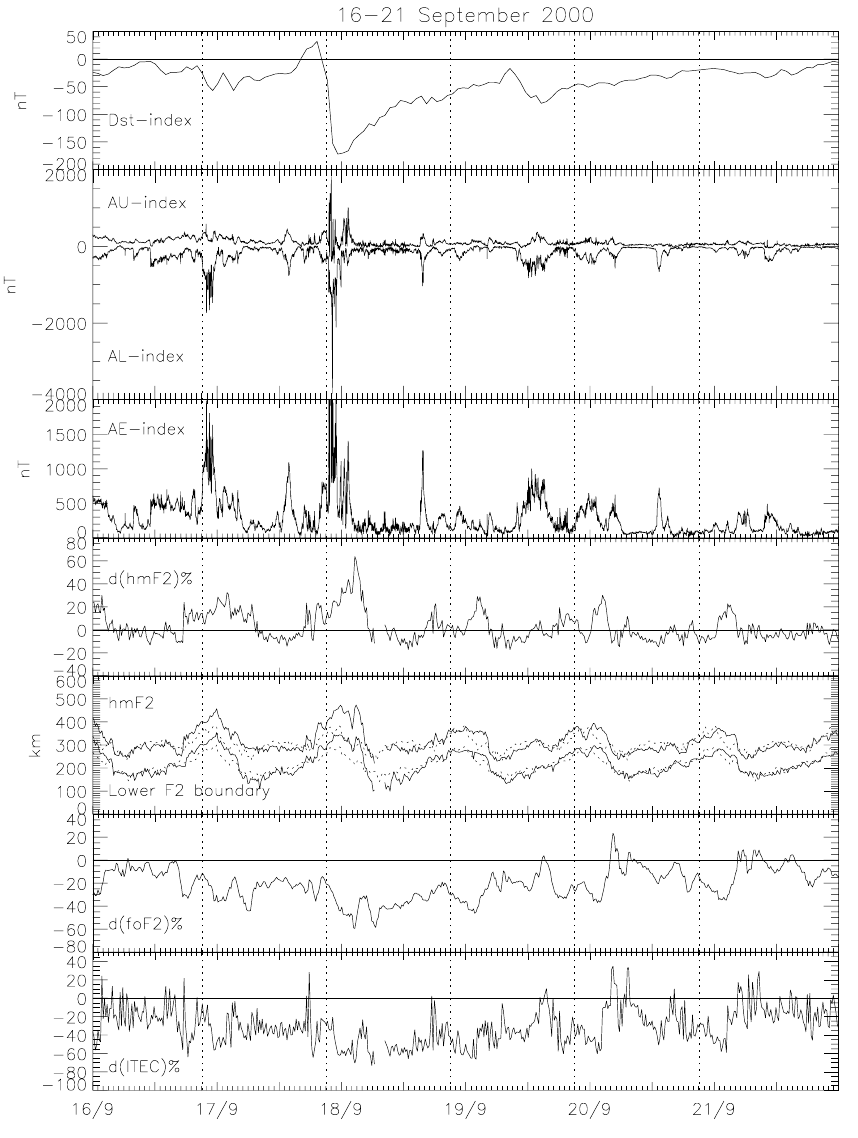
Fig. 3. Same as Fig. 1 for the interval 16–21 September